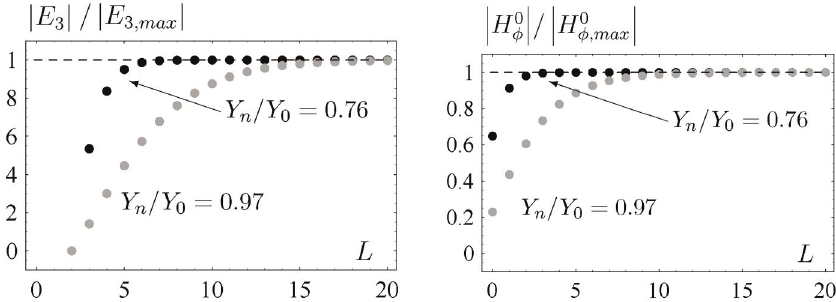
FIG. 10. Convergence of the coefficients (normalized to their limit value) of the final solution as a function of the truncation order L at 1 GHz and for two different conductivity jumps. ( b (cid:1) 2 cm , n (cid:1) 1